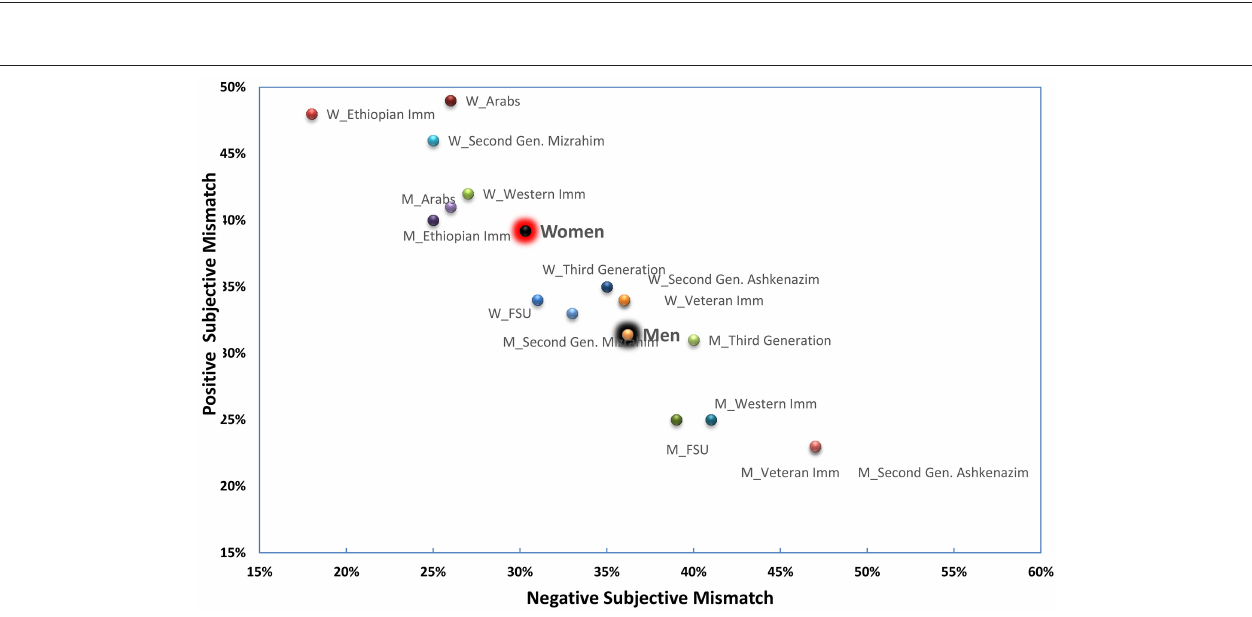
FIGURE 2 | Negative subjective mismatch in the labor market position by ethnicity and gender. Imm. , mmigrants ; Sec. , second ; Miz. , Mizrahim ; Ashk. , Ashkenazim.